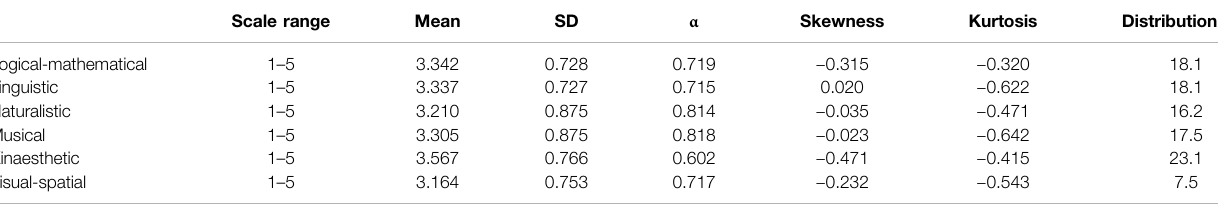
TABLE 2 | Descriptive statistics and distribution of the students ’ learning styles.